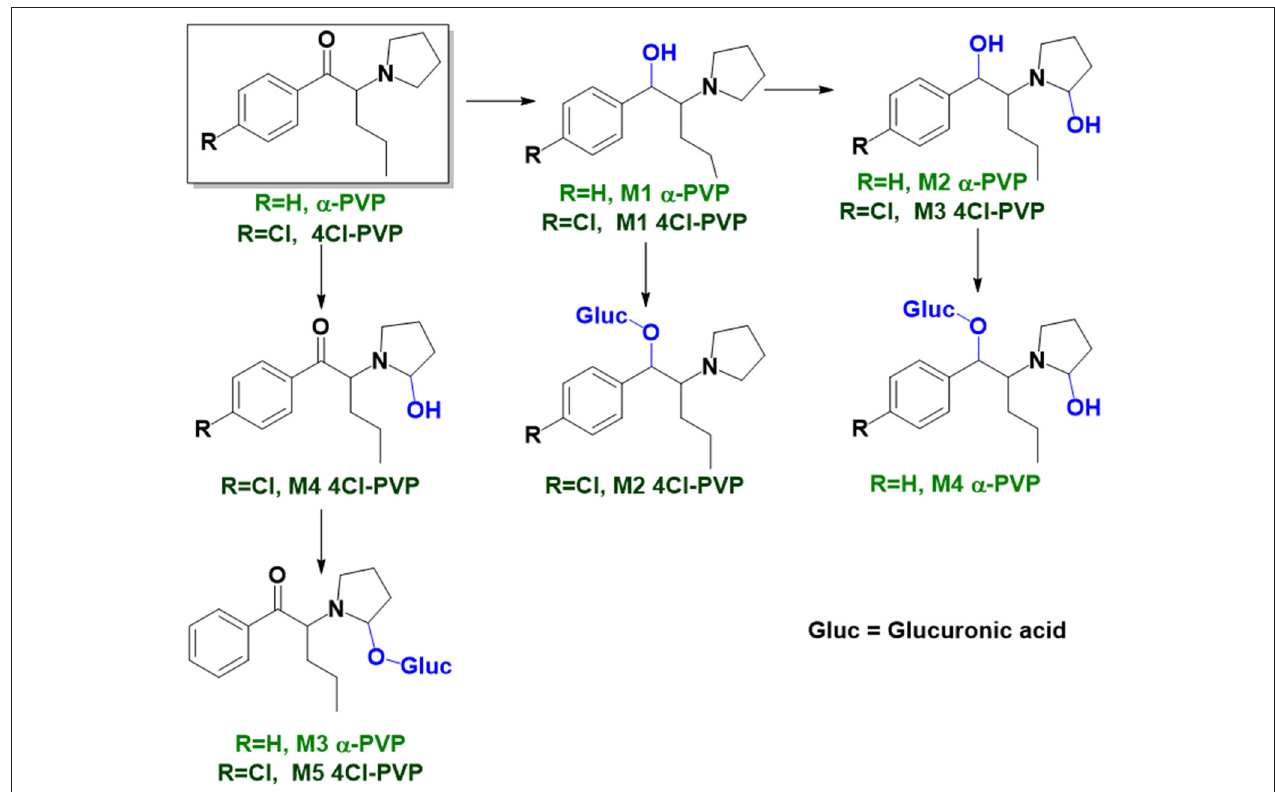
FIGURE 2 | Proposed structures of the α -PVP and 4Cl-PVP Phase I and II metabolites identified by LC-HRMS/MS analysis in HLM and RLM